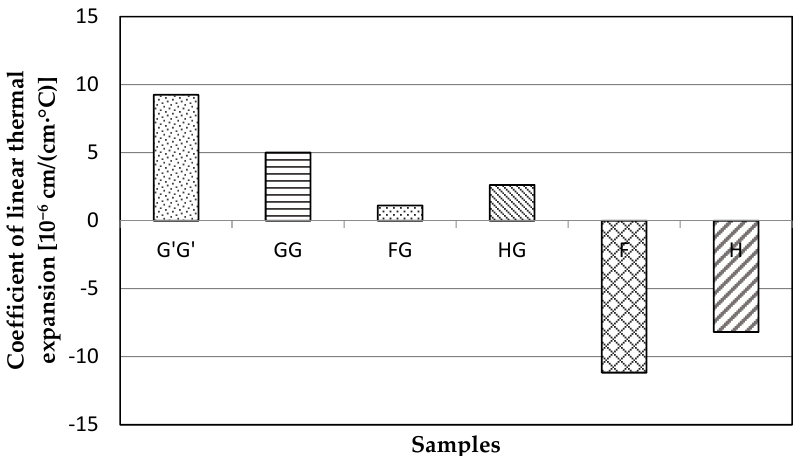
Figure 4. Coefficient of thermal linear expansion for composite samples with commercial glass fiber alone (G’G’), glass fiber (GG), flax and glass fiber (FG), hemp-agave and glass fiber (HG), flax fiber alone (F), and hemp fiber alone (H) measured with ASTM D6341.